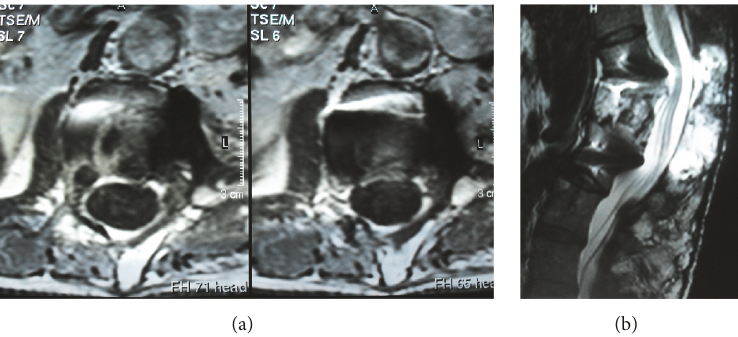
Figure 9: At the fifth year follow-up MRI, axial T 1 WI with gadolinium and sagittal T 2 WI show no